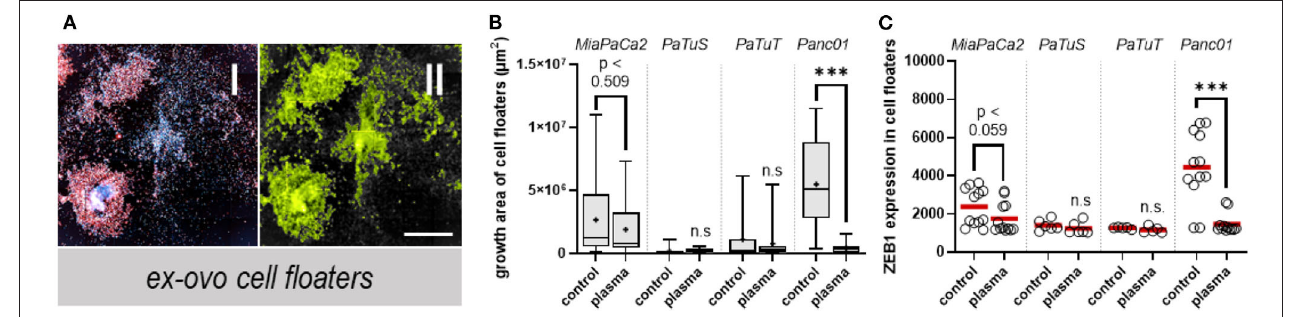
FIGURE 3 | Plasma treatment reduced the growth of ex ovo pancreatic cancer cell floaters. (A) Representative images of MiaPaCa2 cells that detached from in ovo -grown tumors by washing and after seeding them into flat-bottom plates for culture and proliferation in the consecutive 6 days, shown as (I) fluorescence image, and (II) software-processed pseudo-fluorescence image for the quantification of (B) the growth area of detached cell floater cultures, and (C) the expression of ZEB1 analyzed via high content imaging in these cells. Shown are (B) the min-max box-plots and median (black line) and mean ( + ) and (C) the individual values with their mean (red line). The data are technical replicates from at least 4–5 eggs per group. *** p < 0.001. Scale bar is 250 µ